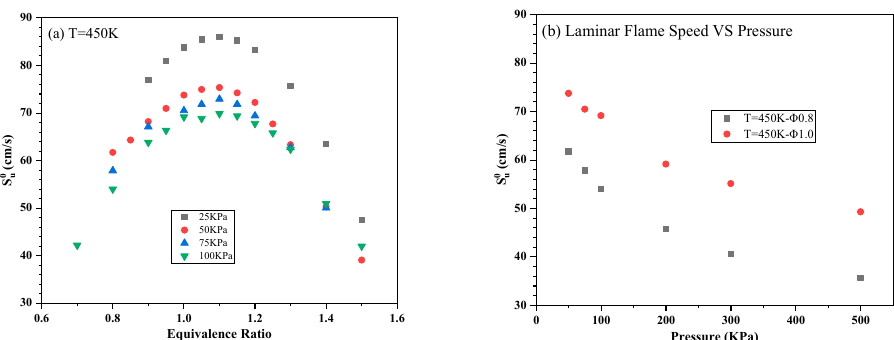
Figure 7. S 0 u of aviation kerosene ( a ) at 450 K and different initial pressures as functions of the equivalence ratio and ( b ) at different initial Φ as functions of the initial pressure.